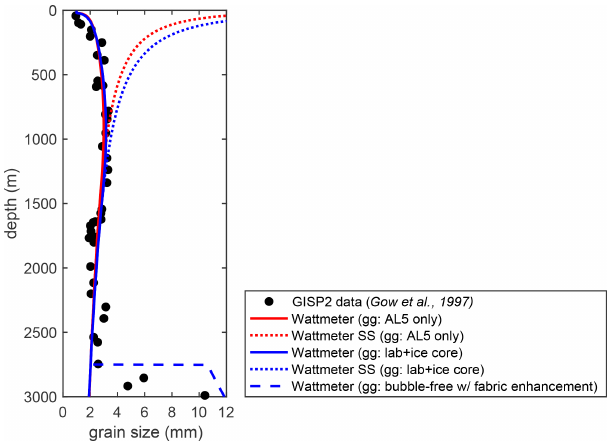
Figure 7. Grain size calculated as a function of depth within the GISP2 ice core. Red and blue curves correspond to calculations us- ing the grain growth parameters from Azuma et al. (2012) exper- iment AL5 and the joint fit of the experimental and ice core data, respectively. Solid curves show time-dependent grain size calcu- lations; dashed curves are the steady-state grain size. The dashed curve shows the calculation in which we use the bubble-free grain growth parameters from Exp. 15 of Azuma et al. (2012) and en- hance dislocation creep by a factor of 10 in the lowermost 200m of ice. The enhancement in dislocation creep is meant to simulate the development of fabric in the basal ice. Black dots show observed grain sizes taken from Gow et al.